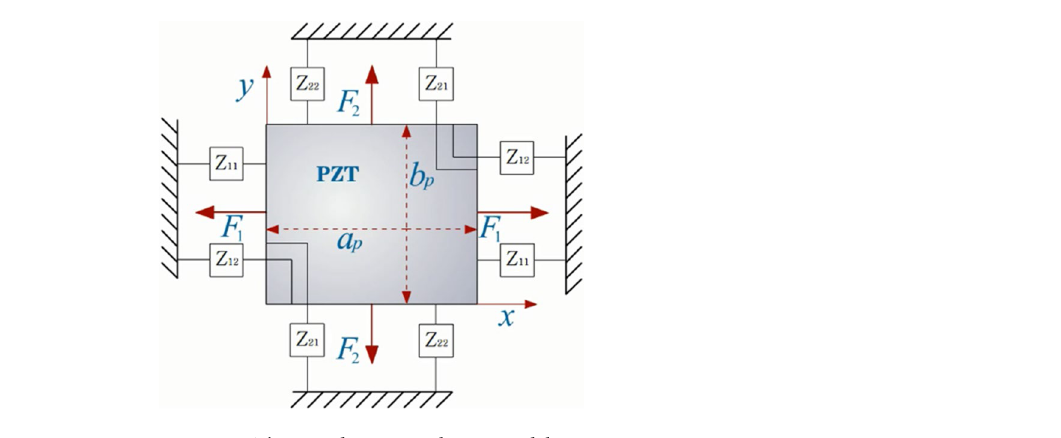
Figure 2. The two-dimensional EMI